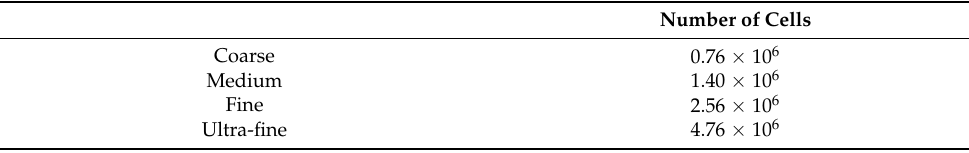
Table 2. Description of meshes used for mesh independence